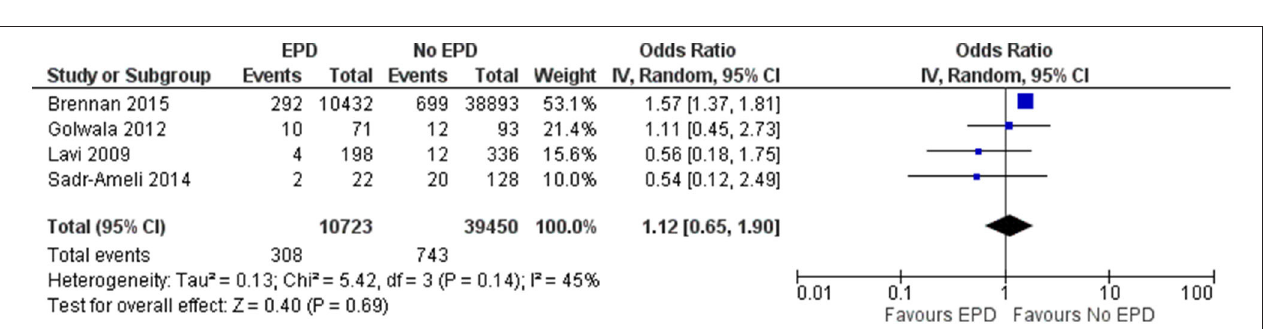
FIGURE 4 | Forest plot showing the difference in periprocedural myocardial infarction (MI) between patients with and without EPD following PCI on SVG ( n =